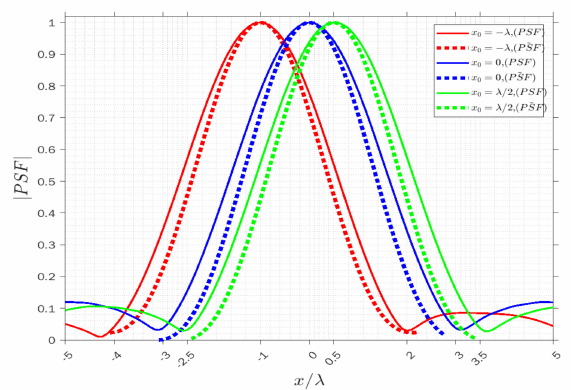
Figure 6. Comparison of the normalized amplitude of the actual (solid lines) and approximated (dashed lines) PSFs for y 0 = − 3 λ (red lines), y 0 = 0 (blue lines) and y 0 = 2 λ (green lines) when x = − λ in angle mode.